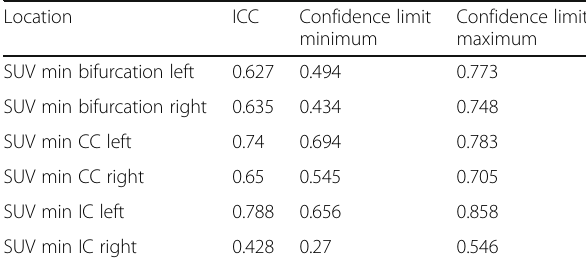
Table 4 ICC for SUVs min with 95% confidence intervals Location